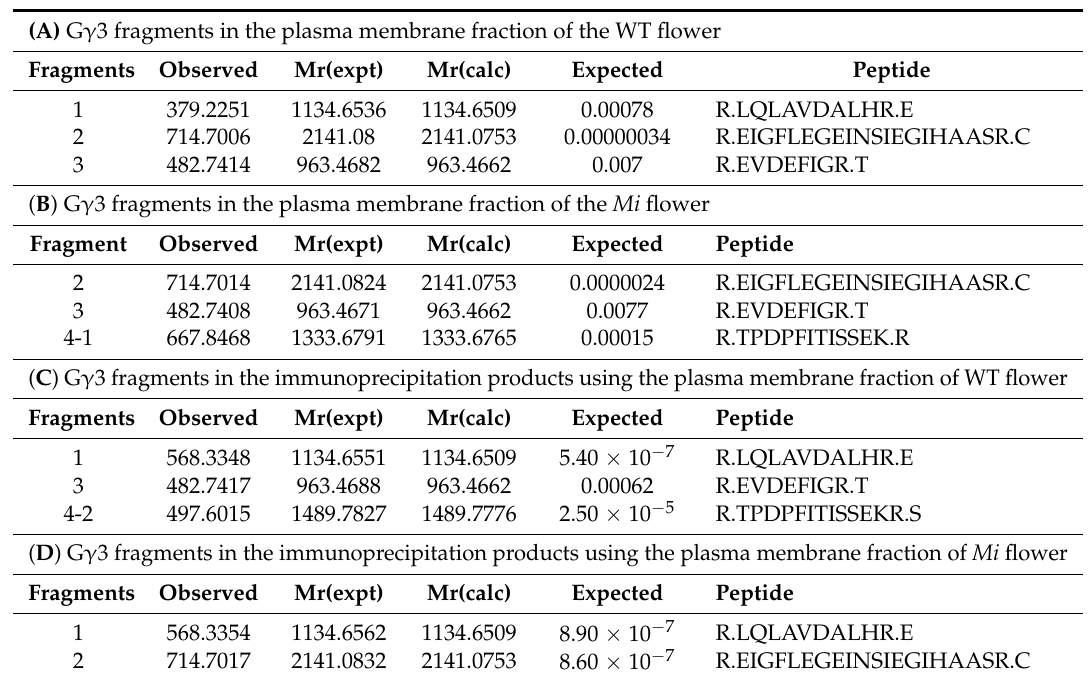
Table 1. LC-MS/MS analysis of G γ 3 fragments in in the plasma membrane of the wild-type (WT) and Minute ( Mi )